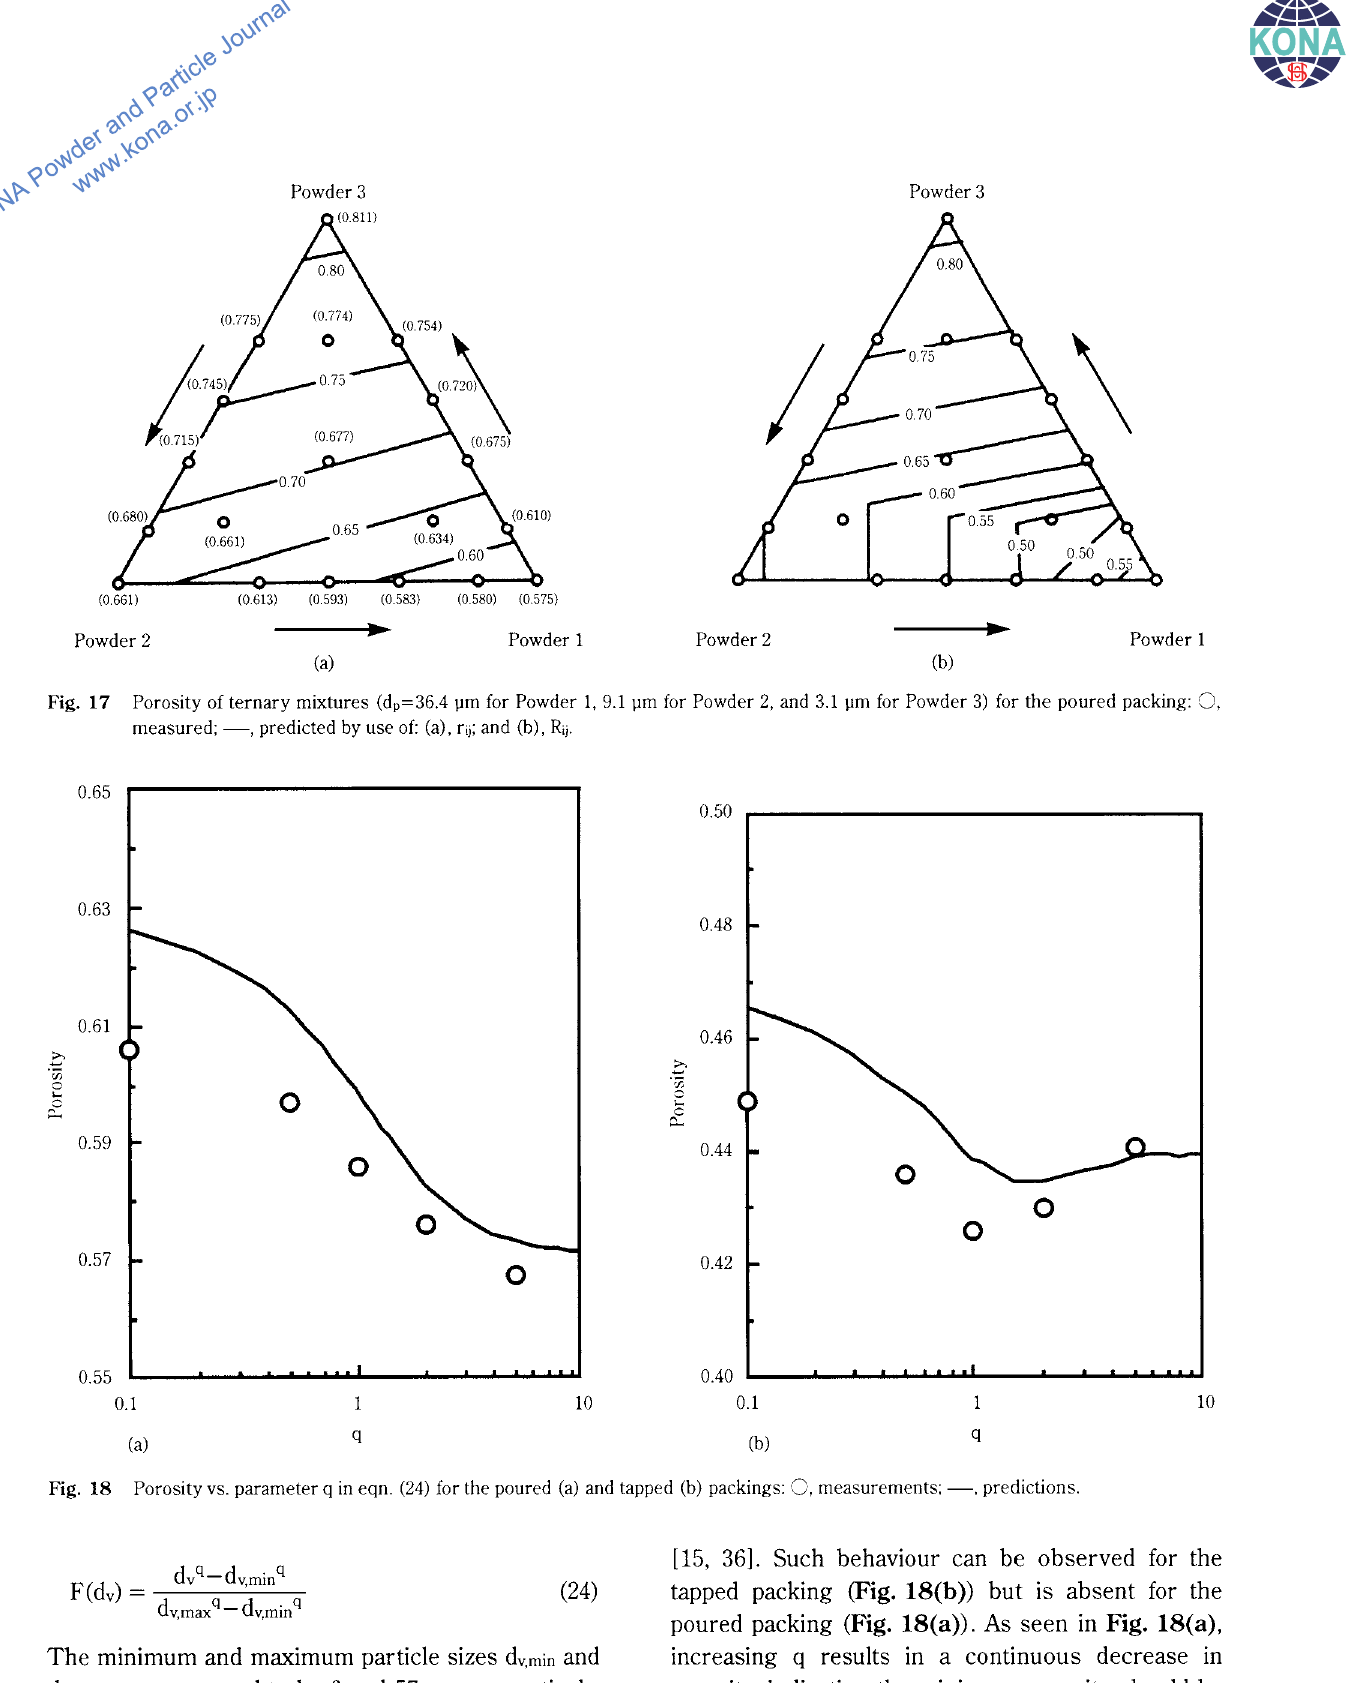
The minimum and maximum particle sizes dv,min and dv,max were assumed to be 6 and 57 !J.m,